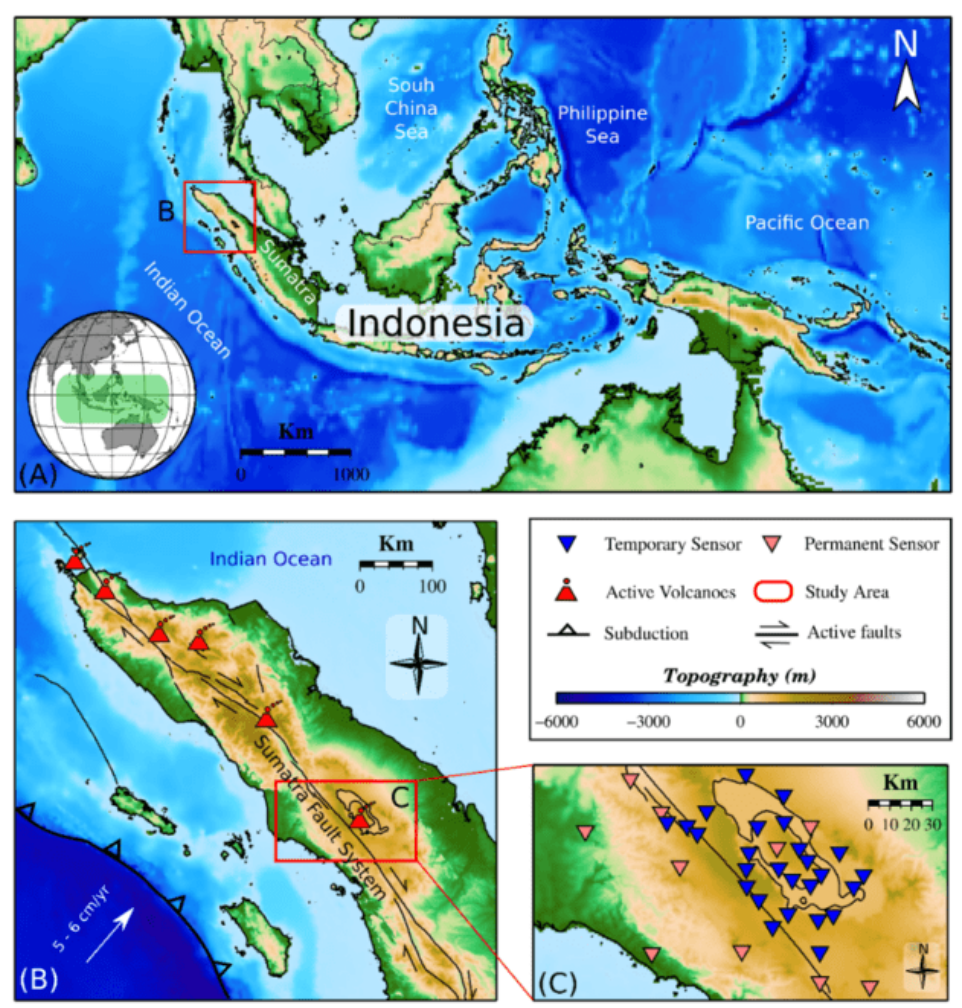
Fig. 1: (a) Geographical map of Indonesia and the study area in the northernmost part of Sumatra. (b) The tectonic map of the northernmost part of Sumatra features active subduction with a geodetic slip rate of 5–6 cm/yr and the Sumatra fault system with active volcanoes. The red square is the boundary area located in Lake Toba and its surroundings. (c) The study area in Lake Toba and its surroundings and the observation points from a temporary sensor (blue triangle) and a permanent sensor (red triangle).